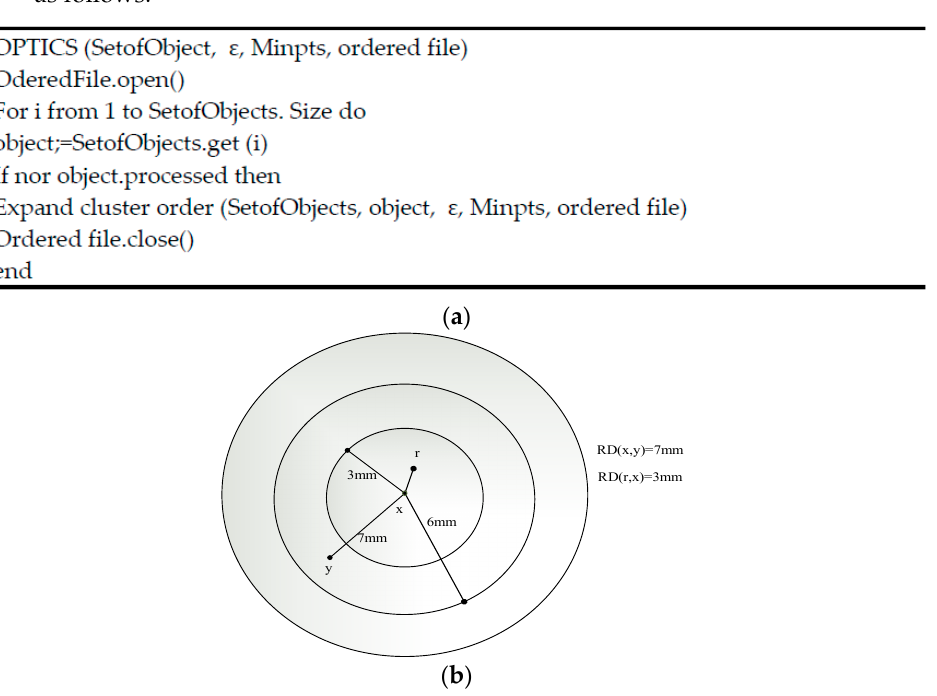
Figure 3. ( a ) OPTICS clustering algorithm. ( b ) Reachability distance.